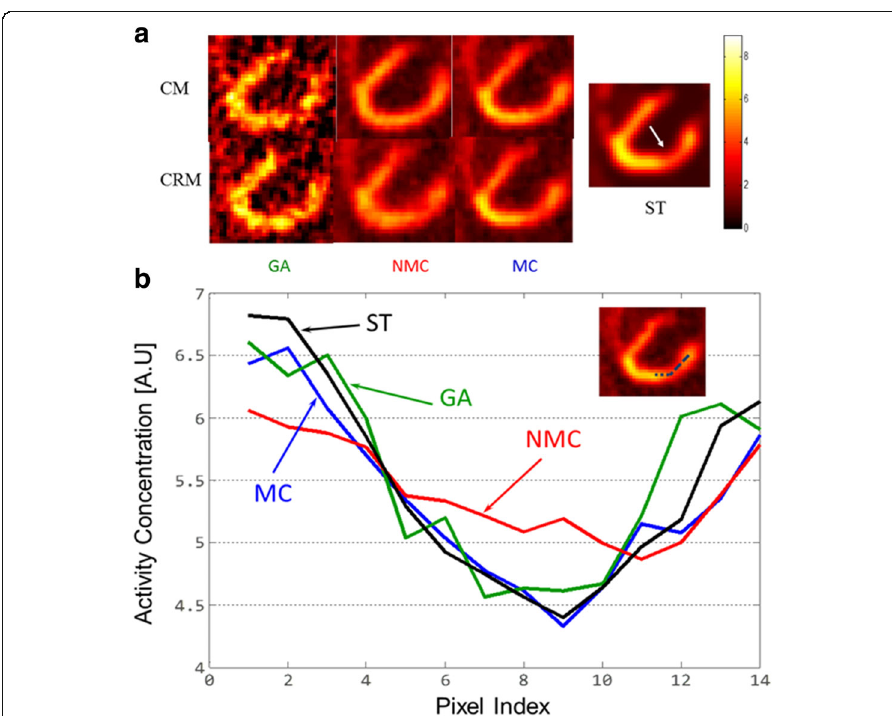
Fig. 3 Reconstructed PET images and line profiles. a Reconstructed GA, NMC, and MC PET images for CM and CRM as well as reconstructed ST PET image. All the images were obtained using the data acquired from four to ten minutes after the injection. The GA, NMC, and MC images are for one noise realization. The arrow on the ST image points to the defect. b GA, NMC, MC line profiles (for CRM) as well as ST line profile. The profiles were drawn along a line (shown on the image at the top-right corner) connecting the anterobasal and apical regions and going through the center of the